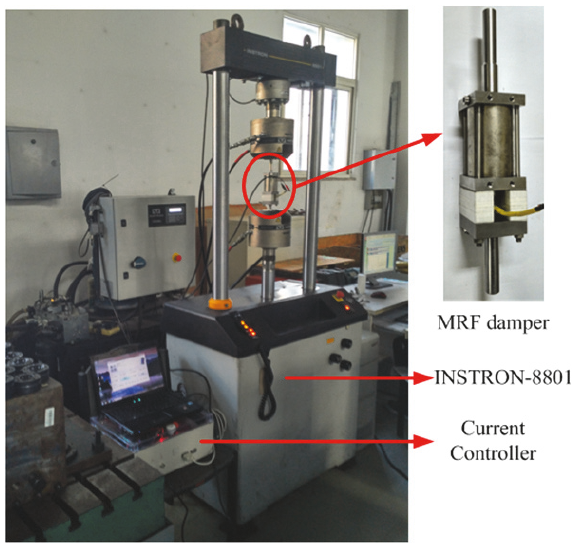
Figure 18: Damping force testing